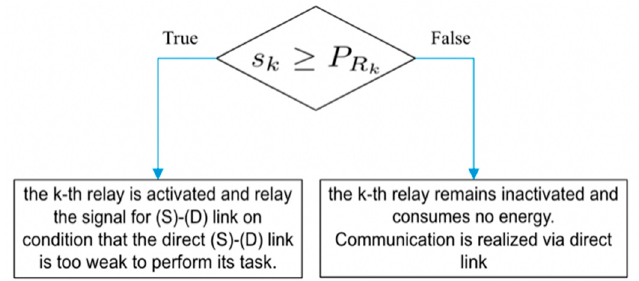
Figure 3. Criteria for choosing the direct or relaying link for information transmission.